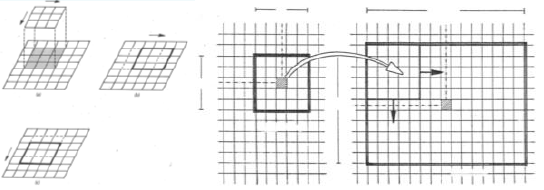
Figure 1: Principle of a moving image kernel (Lemmens,